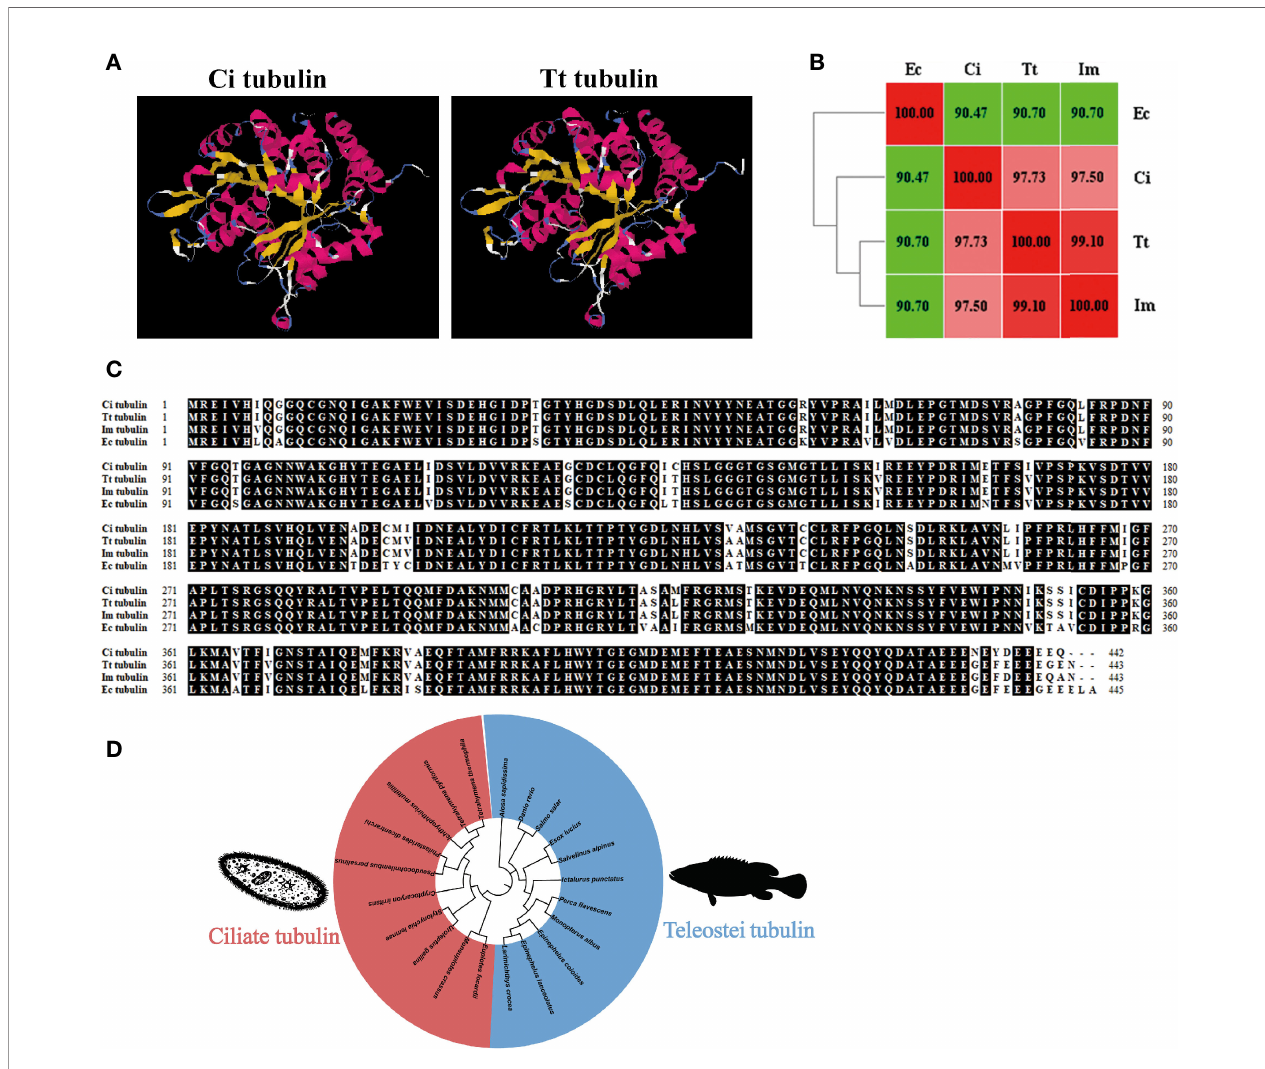
FIGURE 4 | Characterization of ciliate tubulin protein. (A) The 3D homology model of C. irritans tubulin was performed using the T. thermophila tubulin model as a template. (B) Heatmap of the amino acid identity between grouper and ciliates. (C) Sequence alignment of tubulin between grouper and ciliates. (D) Phylogenetic tree between fi sh and ciliate tubulin. A phylogenetic tree illustrating the relationship between fi sh and ciliate tubulin using the neighbor-joining method within the MEGA program. Ec, E. coioides ; Im, I multi fi liis ; Tt, T. thermophila ; Ci, C. irritans